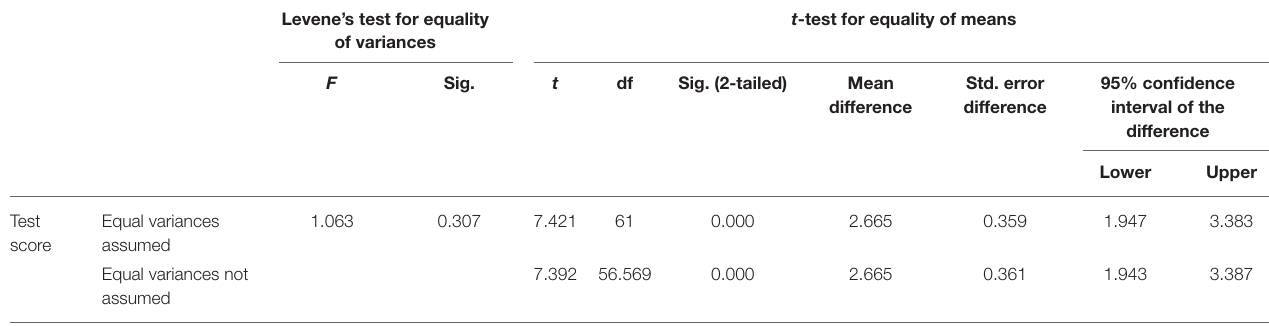
TABLE 5B | Comparison of test scores (Group A vs. Group B) after the treatments.